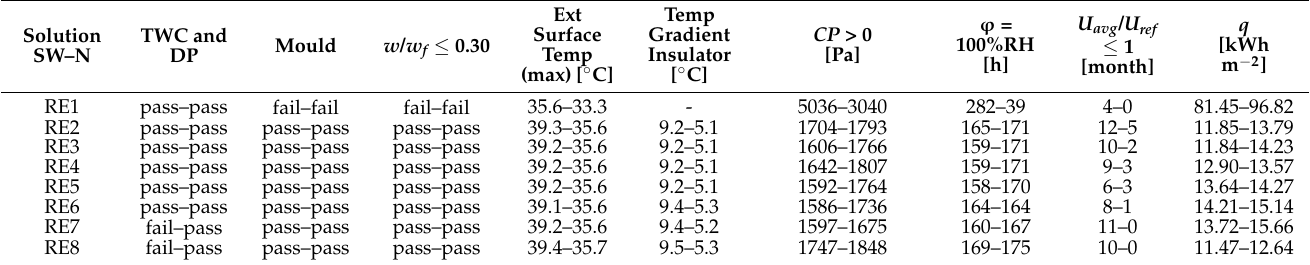
Table 8. Synthesis of the exterior retrofit simulation for Lisbon